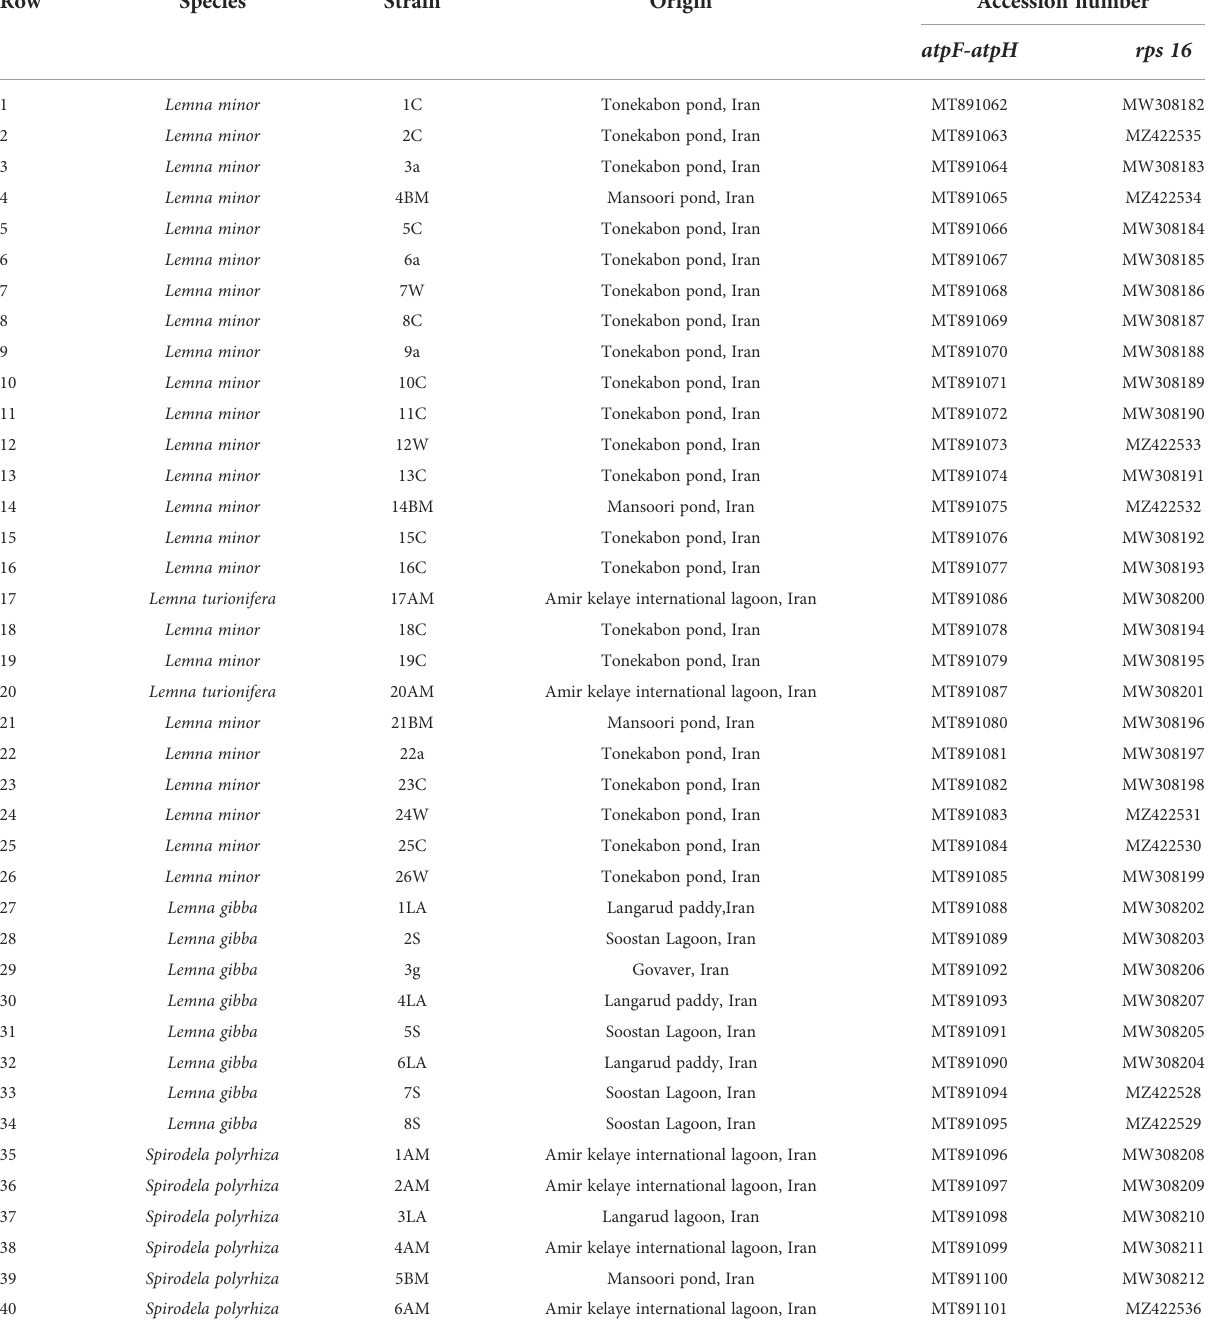
TABLE 1 Duckweed species investigated for this study with their NCBI accession